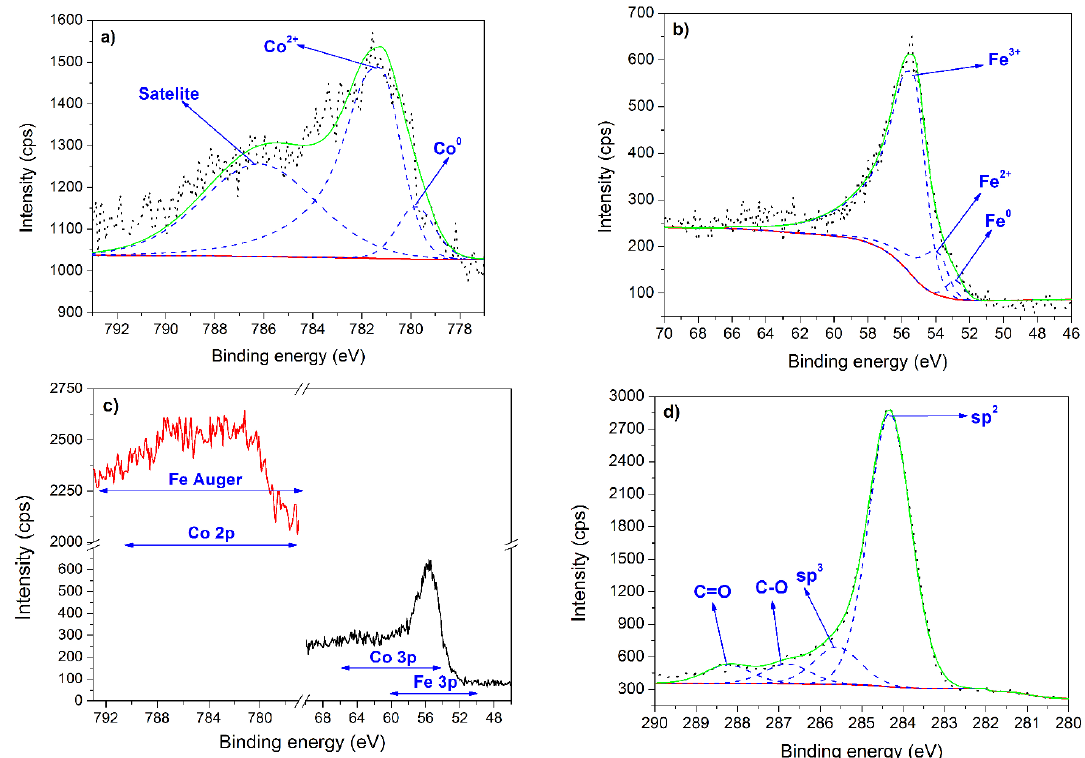
Figure 5. XPS results. ( a ) Co 2p 3/2 spectrum for 1.0Co sample. ( b ) Fe 3p 3/2 spectrum for 1.0Fe sample. ( c ) Co 2p and Fe 3p spectra for 0.61Fe0.39Co sample. ( d ) C 1s spectrum for 0.37Fe0.63Co sample.